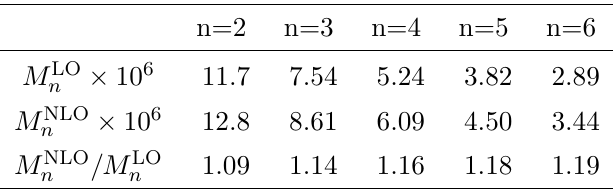
Table 2 . Moments and K -factors for the fragmentation function D b → η µ R = 2 m b